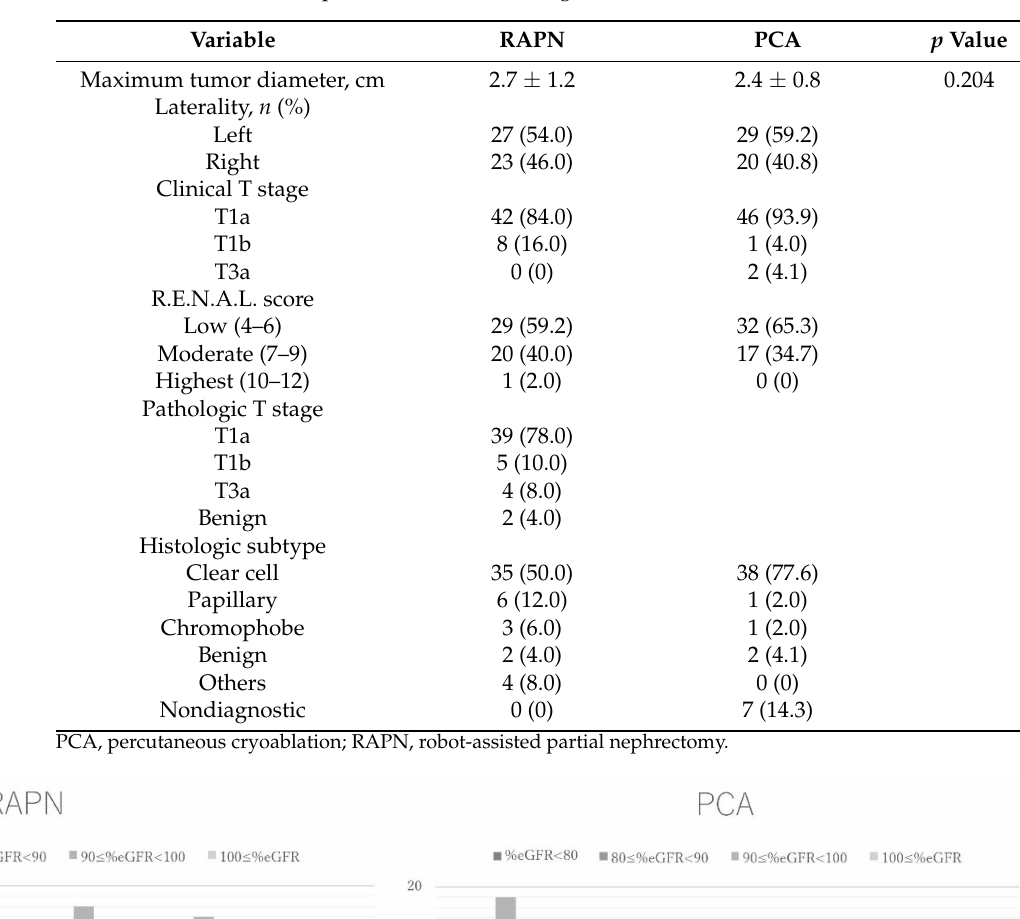
Table 3. Tumor features in patients who had undergone RAPN or PCA.